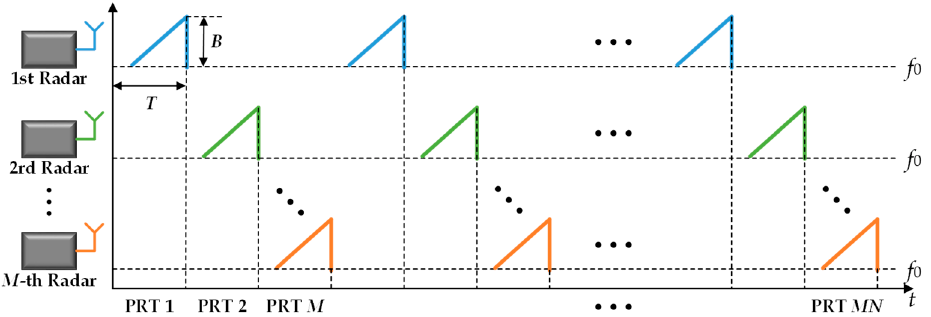
Figure 2. The fast chirp sequence waveform used in the MMW DCAR with time-division method.